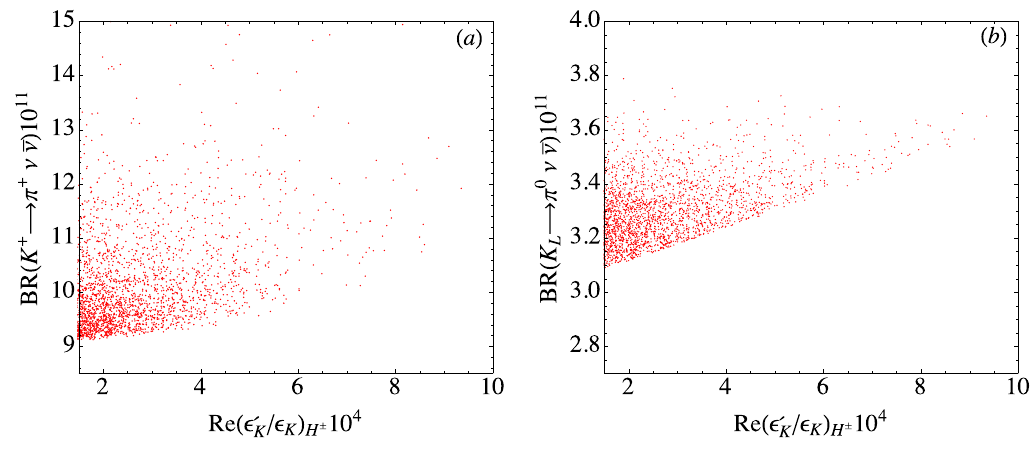
(cid:25) + (cid:23) (cid:22) (cid:23) ) and BR ( K L !